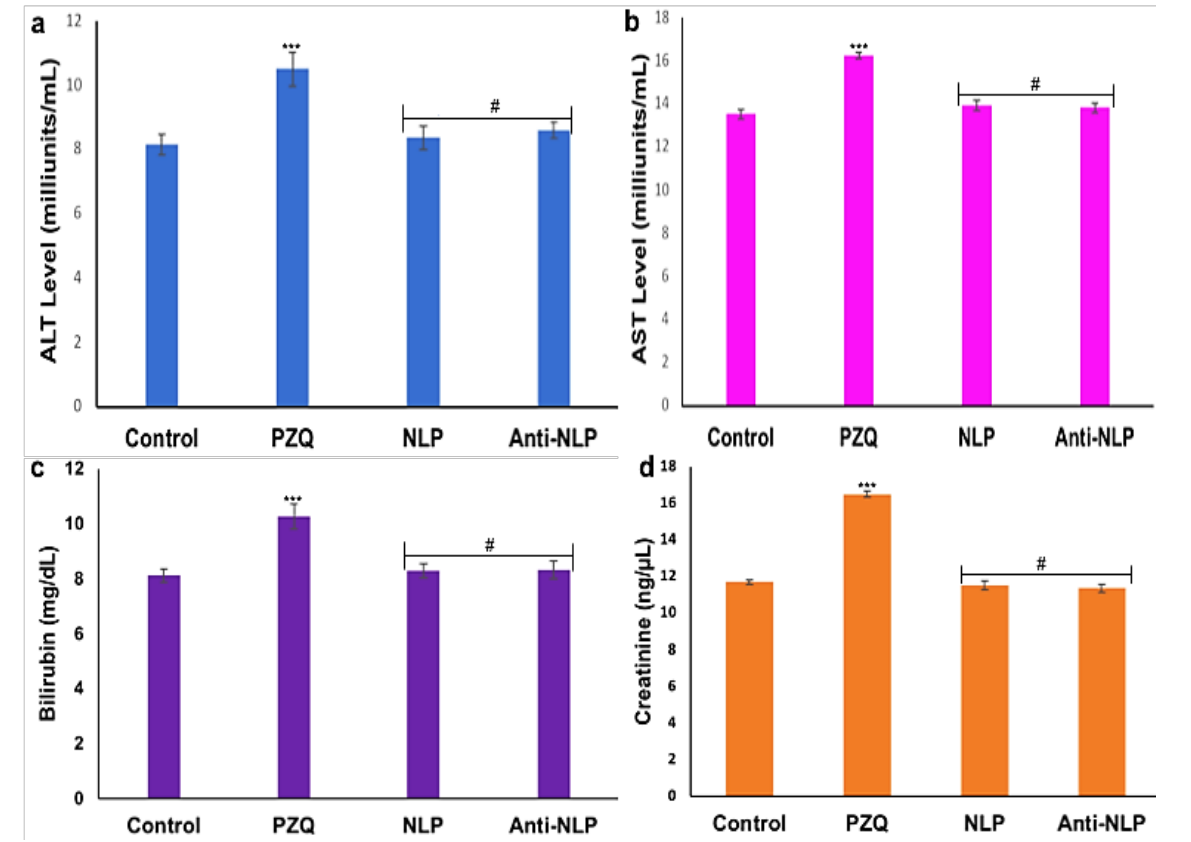
Figure 10. Biochemical markers ( a ) ALT ( b ) AST ( c ) Bilirubin and ( d ) creatinine levels in plasma. Values are expressed as mean ± standard deviation of five determinations (data represent n = 3, mean ± SD). *** indicates p < 0.0001 when compared to the control group, and # indicates p < 0.0001 when compared to the PZQ group.